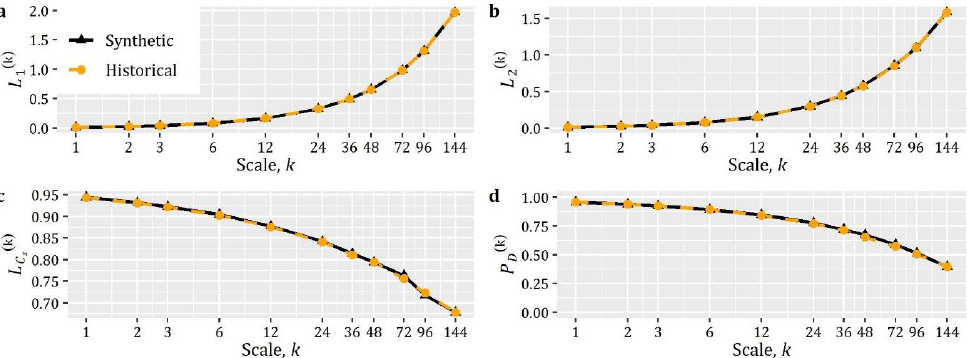
Figure 10. Comparison of historical (empirical) and synthetically (disaggregated) generated data, as a function of aggregation scale 𝑘 ∈ {1,2,…,144} , in terms of: ( a ) L-mean ( 𝐿 1(𝑘) ); ( b ) L-scale ( 𝐿 2(𝑘) ); ( c ) L- skewness ( 𝐿 𝐶𝑠(𝑘) ); and ( d ) probability dry ( 𝑃 0(𝑘) ).